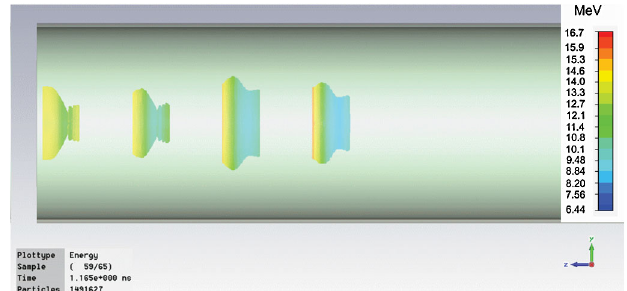
12. Right side view of four drive bunches, initially cen- tered on the structure axis, moving from right to left, along a cylindrical collinear DWA structure specified in Table II. The color scale on the right shows the energy of the particles. These drive bunches are spaced apart by one period of the design mode and are shown after 1.16 nsec of